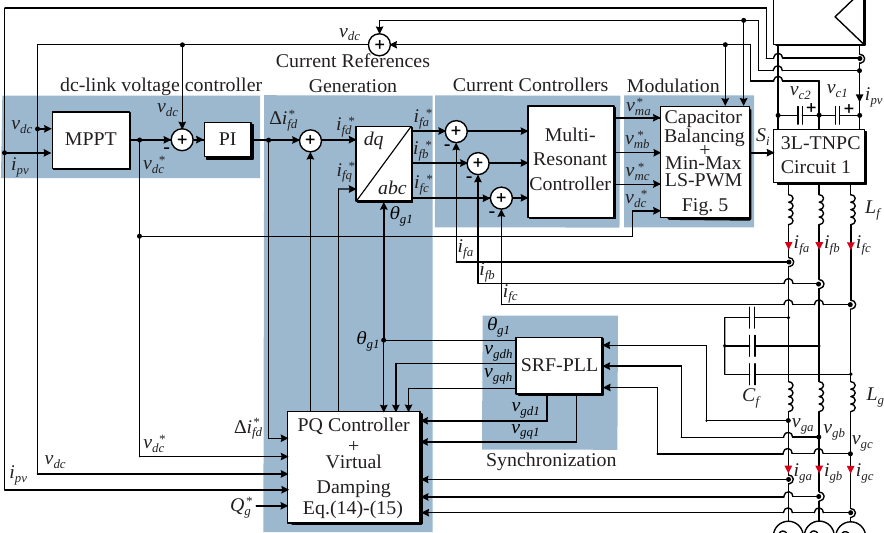
Figure 3. Enhanced VOC for 3L-TNPC